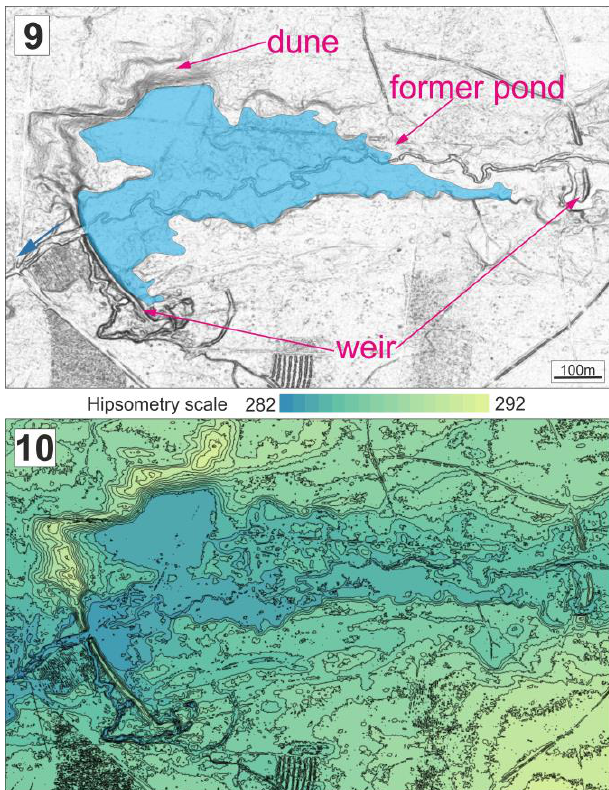
Fig. 10. Location of the former ironworks near the town of Kalety: 9 – on the shaded relief map; 10 – on the coloured contour